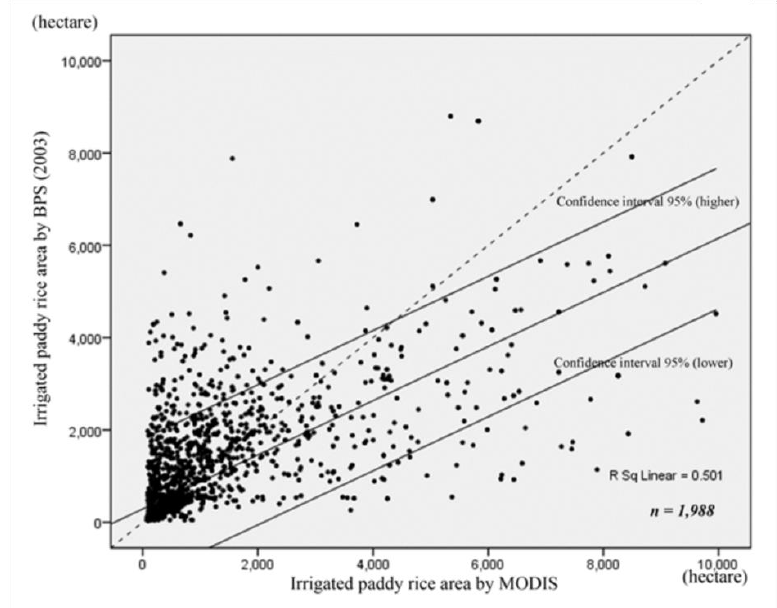
Figure 10. Comparison of the paddy field area estimated by this study and the statistical